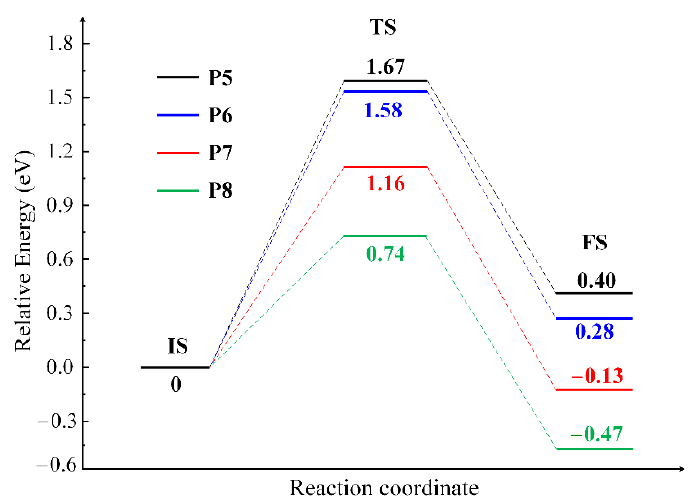
Figure 9. Potential energy diagram for the O anion diffusion processes in different pathways on the CuO(111) surface.